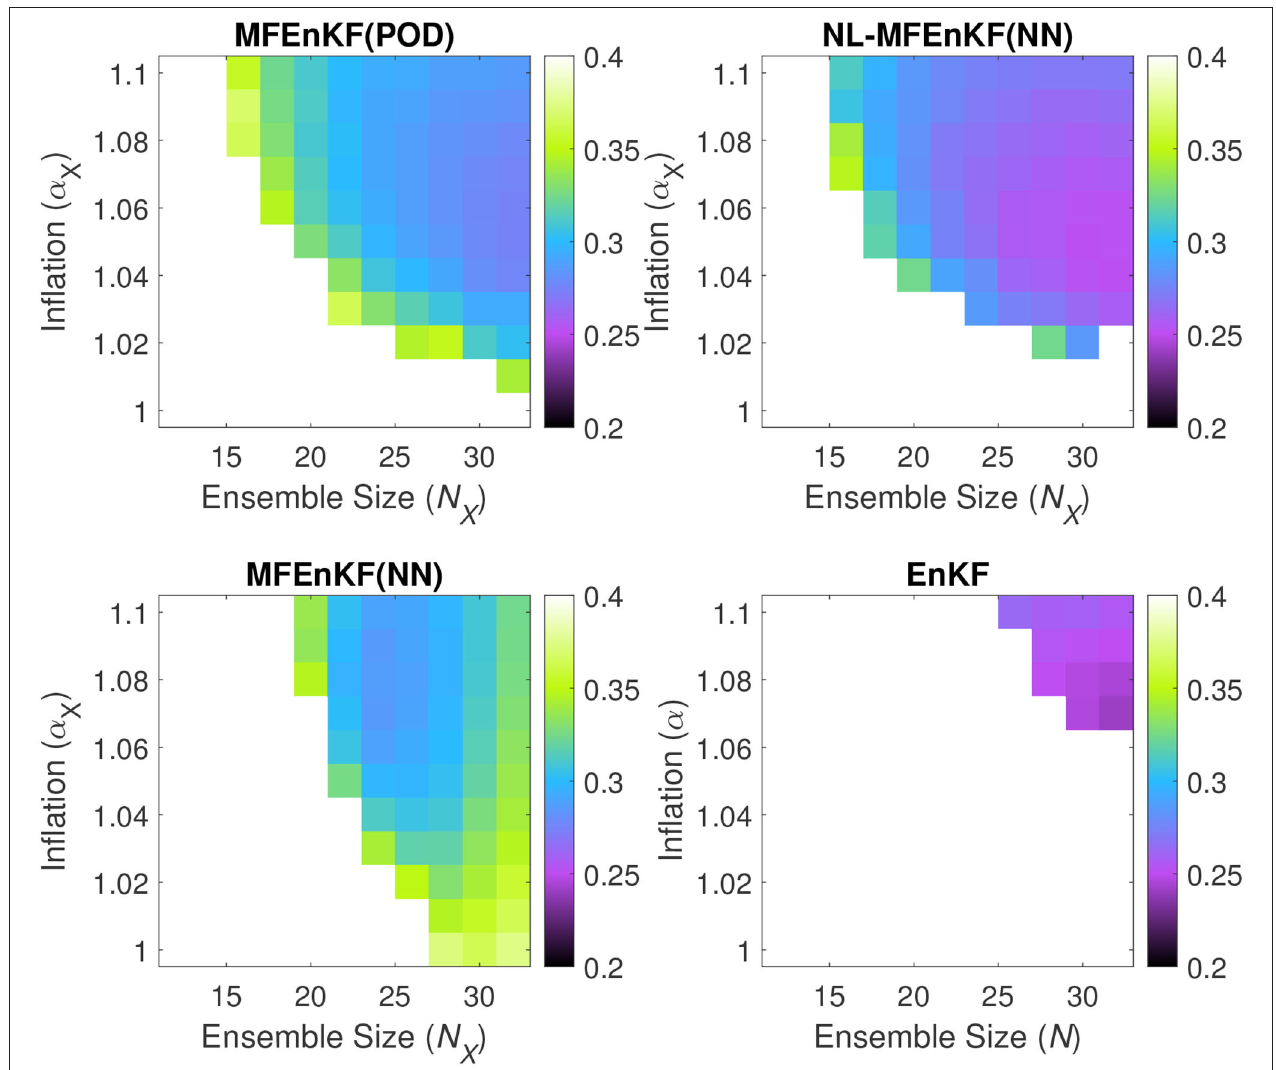
FIGURE 4 | Lorenz’96 analysis RMSE for four data assimilation algorithms and various values of the principal ensemble size N X and inflation factor α X . The surrogate ROM size is fixed to r = 28 with ensemble size of N U = 25 and inflation of α U = 1.01. The (top left) represents the MFEnKF with a POD-ROM surrogate, the (top right) represents the NL-MFEnKF with a NN-ROM, the (bottom left) represents the MFEnKF with a NN-ROM surrogate assimilated in the principal space, and the (bottom right) represents the classical